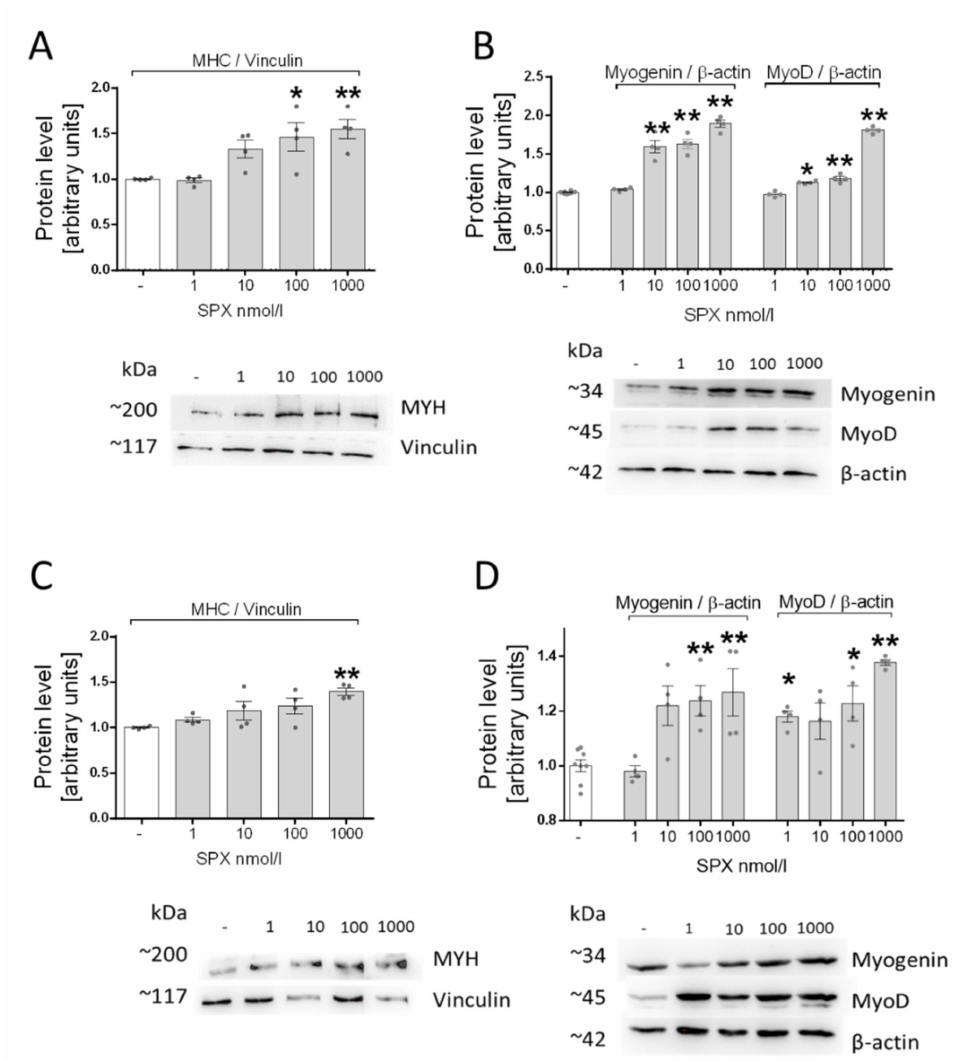
Figure 4. The effect of SPX on MYH ( A ), myogenin and MyoD ( B ) protein expression after 2 days and MYH ( C ), myogenin and MyoD ( D ) after 6 days. Values are presented as mean ± standard error of the mean (S.E.M.) ( n = 4). Statistically significant differences are marked for p < 0.05 (*) and p < 0.01 (**) compared to the corresponding